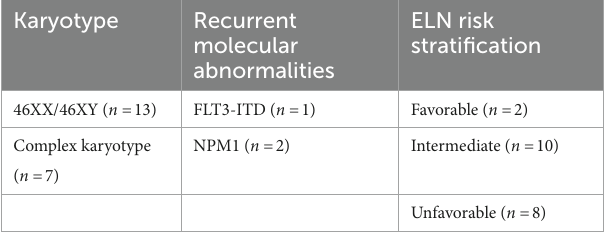
TABLE 2 Risk stratification of AML cases based on their karyotype and recurrent molecular